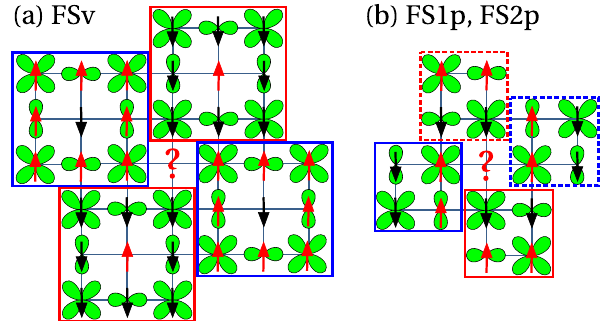
FIG. 11. Isotropic surrounding of the degenerate impurity spins in the FS v and FS p phases in the case of x ¼ 1 = 5 periodic doping (Fig. 10). Frames mark the clusters that are not connected with orbitally active